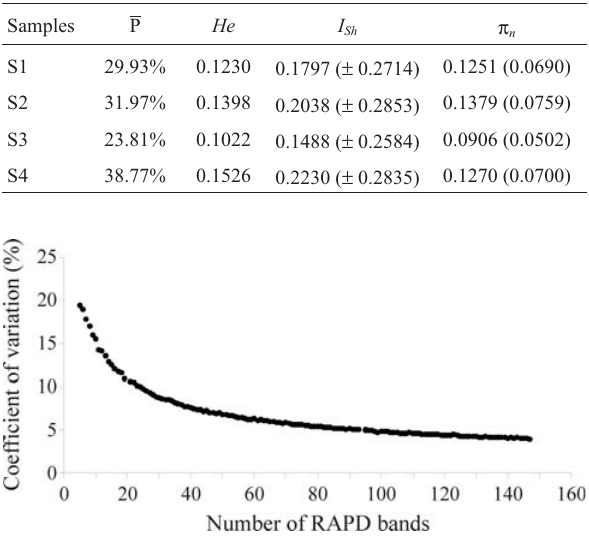
Figure 3 - Relationship between different number of RAPD bands and co- efficients of variation (%) for errors associated with genetic similarity among H. ancistroides genotypes, based on Jaccard